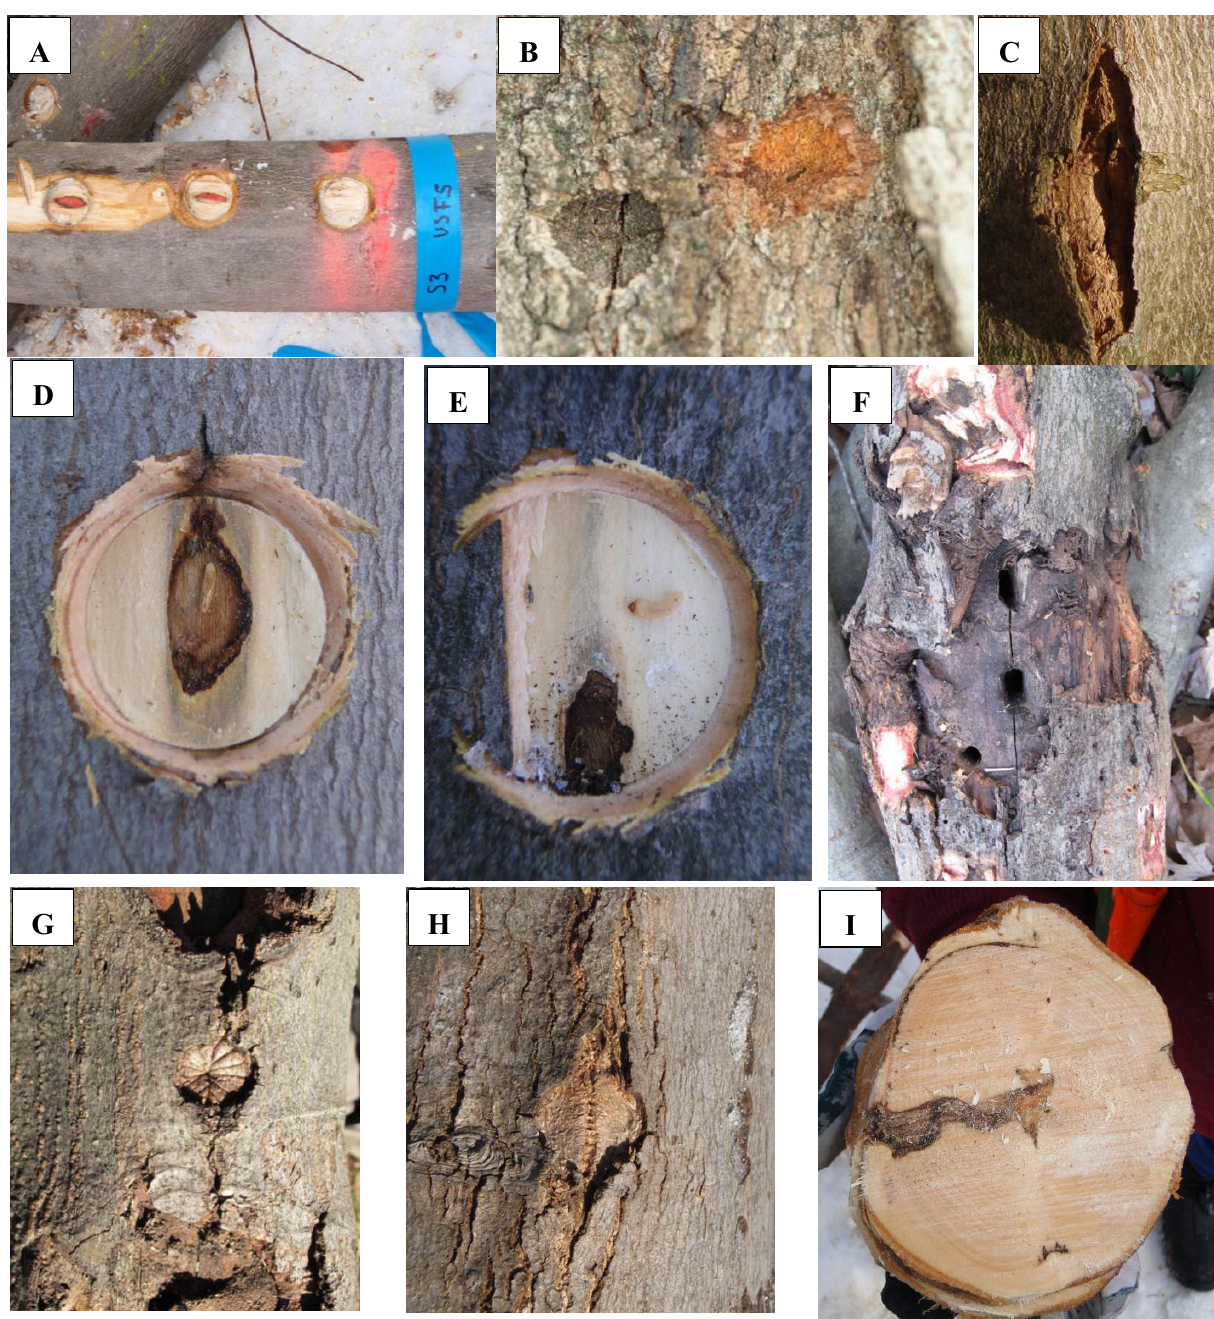
Figure 2. Log section with bark removed from oviposition pits ( A ). Older (left) and recent (right) Asian longhorned beetle (ALB) oviposition pits on infested maple ( B ). Calloused ALB oviposition pit ( C ). Dissection of oviposition pit showing egg ( D ). Dissected oviposition pit with ALB larva and indications of larval feeding ( E ). ALB late larvae sapwood entrance holes (oval holes, center) and an exit hole (bottom, left) ( F ). Calloused ALB exit hole ( G , H ). Infested tree cross section following ALB development through to an exit hole ( I